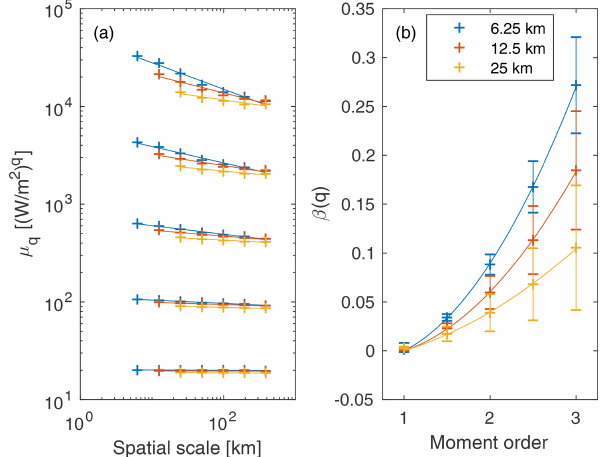
Figure 8. The spatial scaling of modelled heat fluxes in the Central Arctic region over JFM 2007. The two panels are the same as in Fig. 5, but here the colours denote results from runs at different model